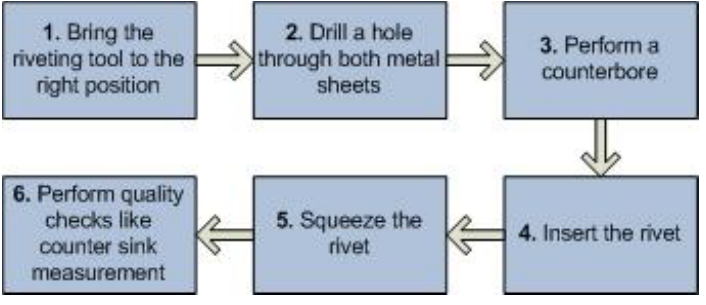
Figure 11. Sequence of setting a